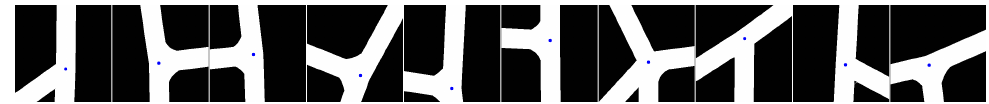
Figure 9. More examples of MBEV images generated with the model in Figure